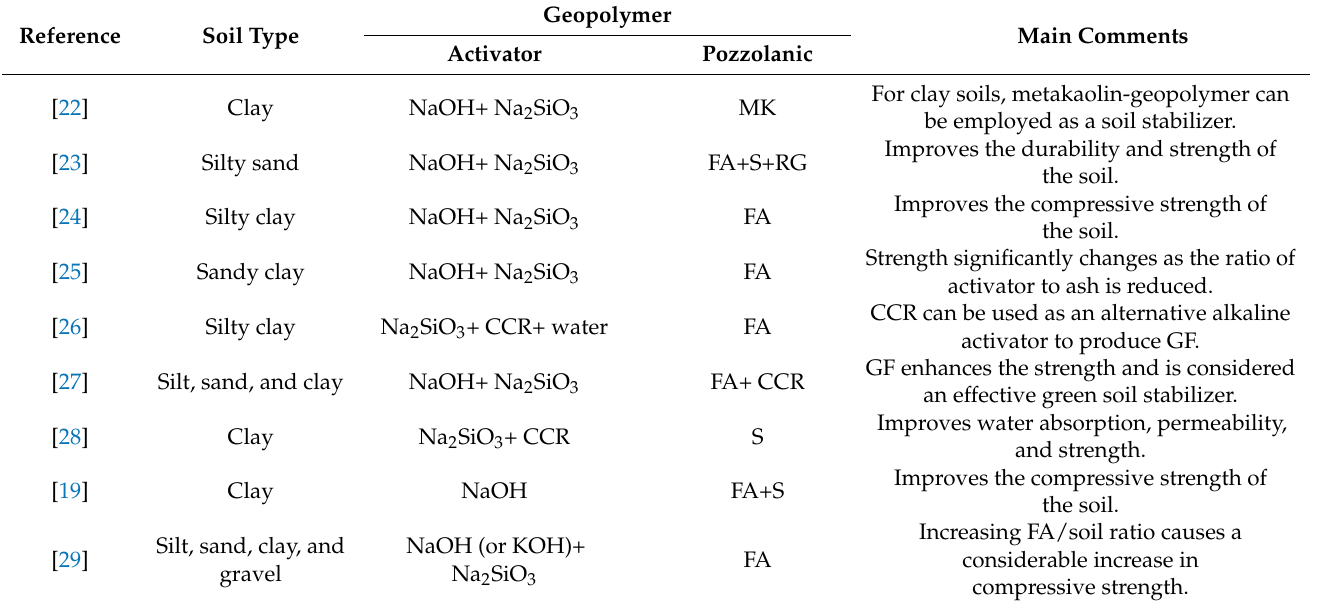
Table 1. Using geopolymers as an effective stabilizer for